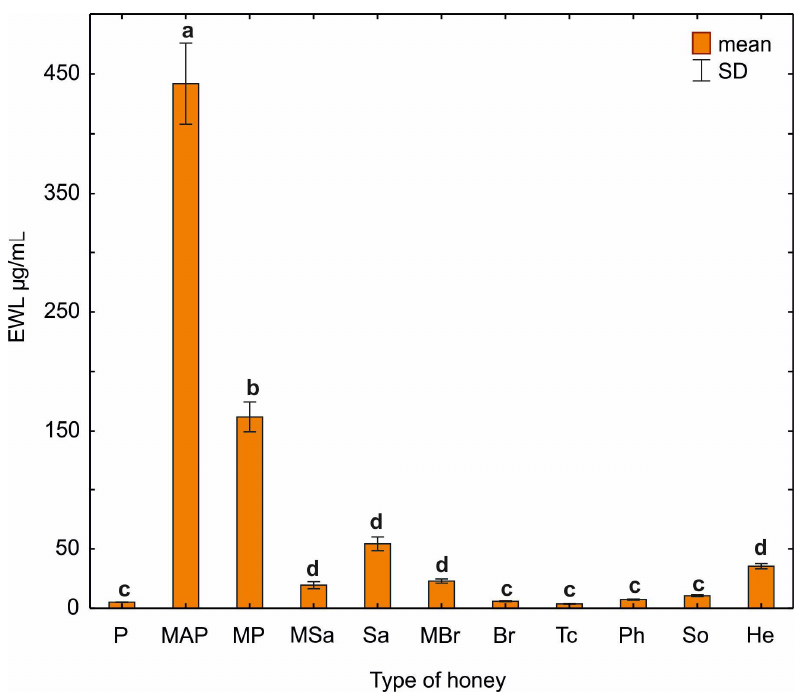
Figure 8. Lysozyme-like activity was determined by the radial diffusion assay and presented as an equivalent of EWL activity (µg/mL). Statistical differences are marked with different letters and their significance at p ≤ 0.001 with capital letters, p ≤ 0.05 with lowercase letters.